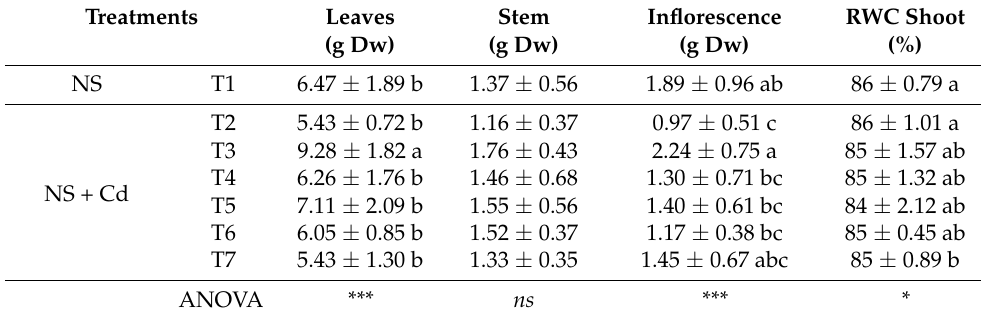
Table 2. Growth parameters: dry biomass of the leaves, stems, and inflorescences, and the relative water content of the shoot (RWC) obtained at the end of the experiments with plants grown under Cd toxicity conditions and treated with different active materials to mitigate this toxicity (T1: NS, T2: NS + Cd, T3: NS + Cd + BioG, T4: NS + Cd + Se1, T5: NS + Cd + Se2, T6: NS + Cd + chitosan1, and T7: NS + Cd + chitosan2).